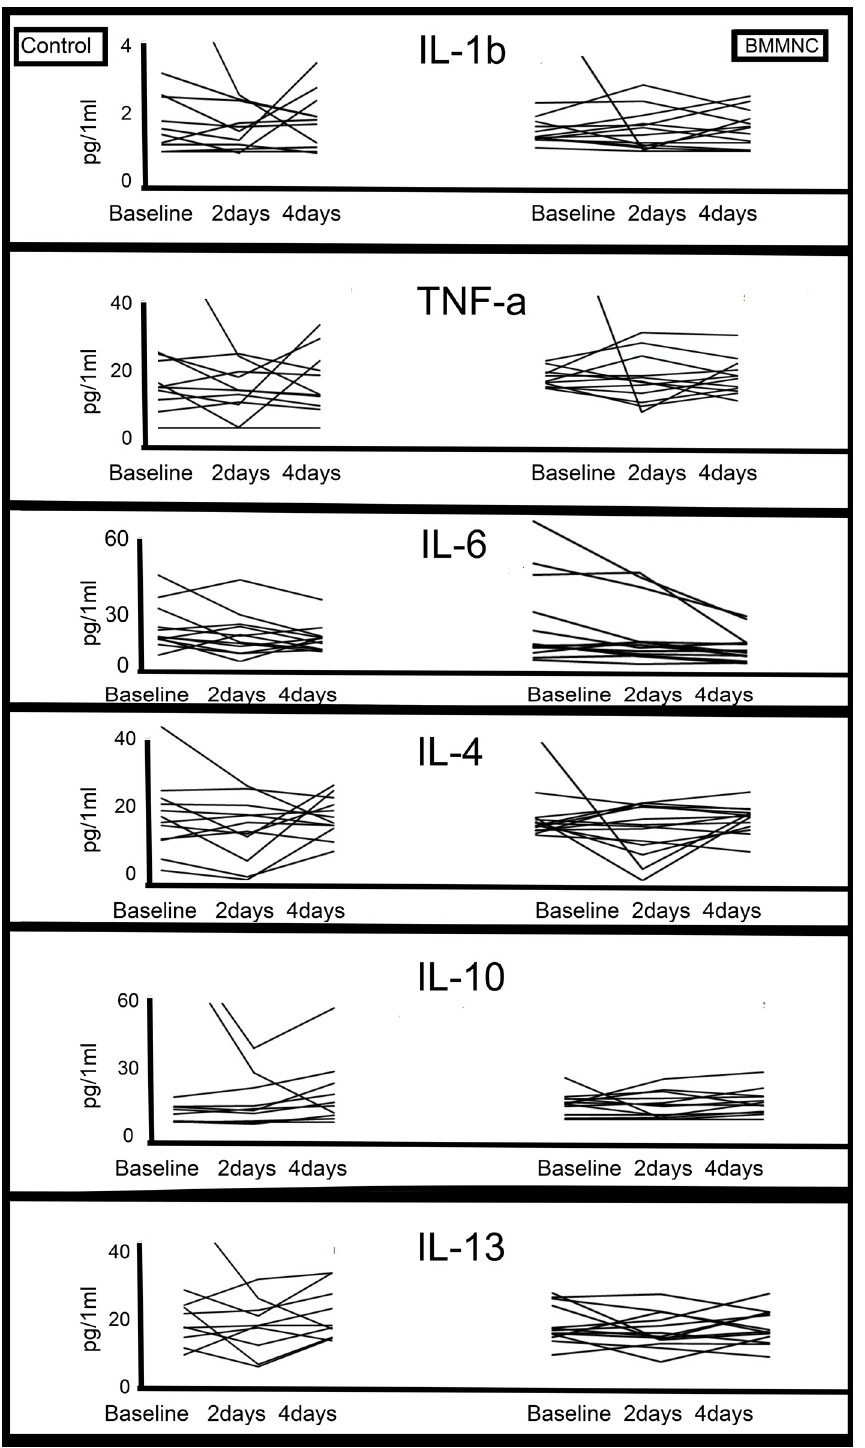
Fig 2. Cytokine levels of single patients. Due to high variability among cytokine concentrations of the single patients, no clear trend in levels existed in either study groups. This illustrates the complexity of cytokine network and systemic factors contributing on inflammation process and cardiac